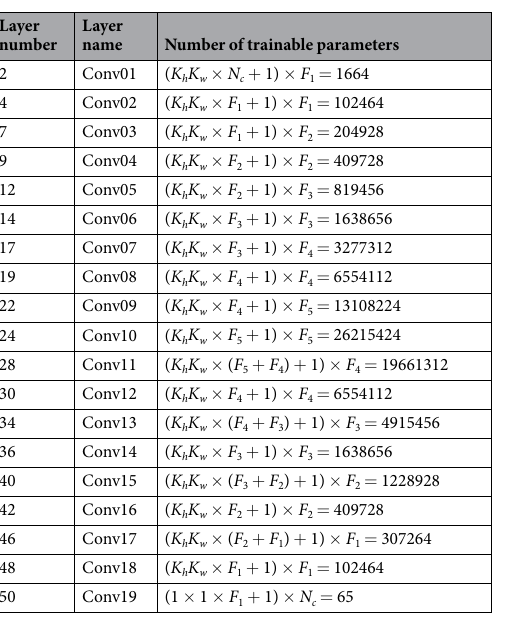
Table 1. Model summary for the model architecture shown in Fig. 1, where N c = 1, F 1 = 64, F 2 = 128, F 3 = 256, F 4 = 512, F 5 = 1024, and K h K w = K h × K w . K h = K w = 5 denote the height and width of the convolution kernel, respectively. The first layer is an input layer. The layers numbered 3, 5, 8, 10, 13, 15, 18, 20, 23, 25, 29, 31, 35, 37, 41, 43, 47, and 49 are (18) activation layers. The layers numbered 6, 11, 16, and 21 are (4) max-pooling layers. The layers numbered 26, 32, 38, and 44 are (4) up-sampling layers. The layers numbered 27, 33, 39, and 45